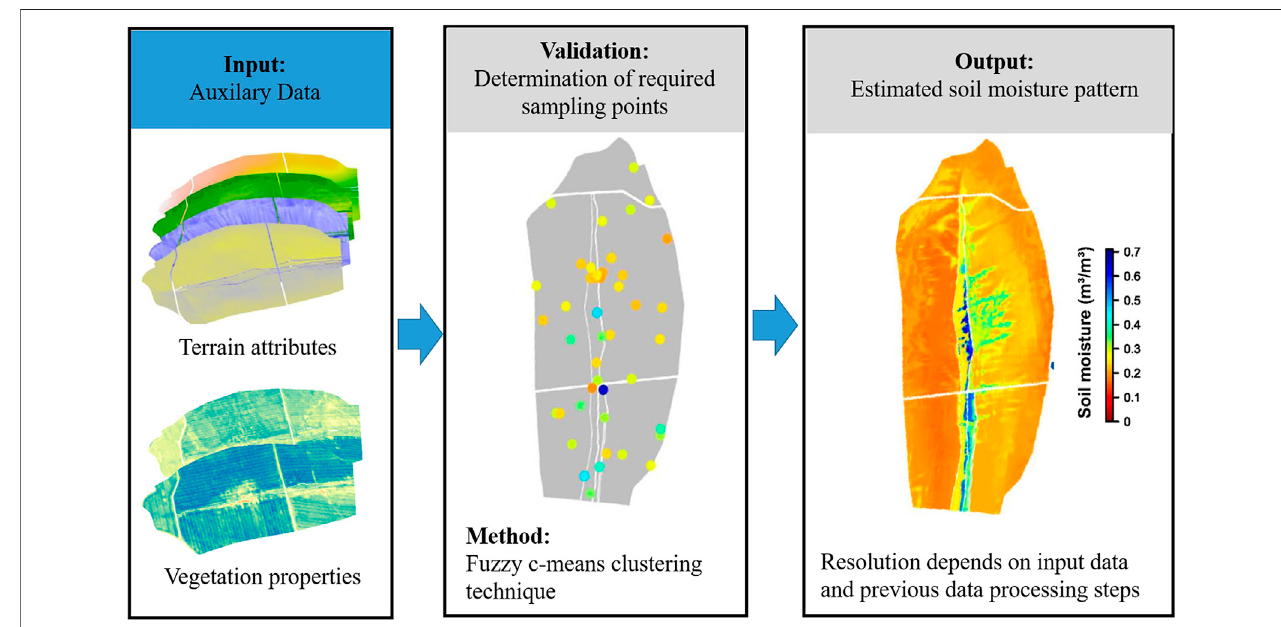
FIGURE 9 | Simpli fi ed fl ow chart of the fuzzy c-means sampling and estimation approach (FCM SEA) with combined integration of terrain attributes and red-edge based normalized difference vegetation index patterns (after Schroeter et al., 2017).